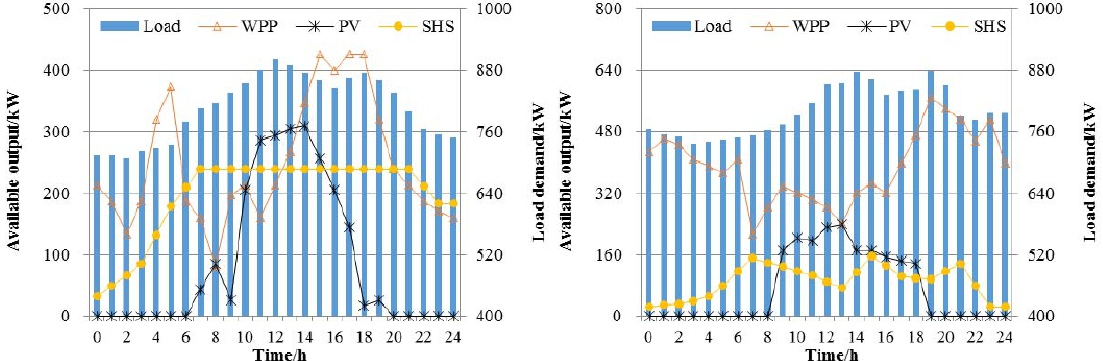
Figure 5. Load demand and available output on typical load day: ( left ) summer and ( right ) winter. Table 1. Parameters of PBDR and IBDR in typical load